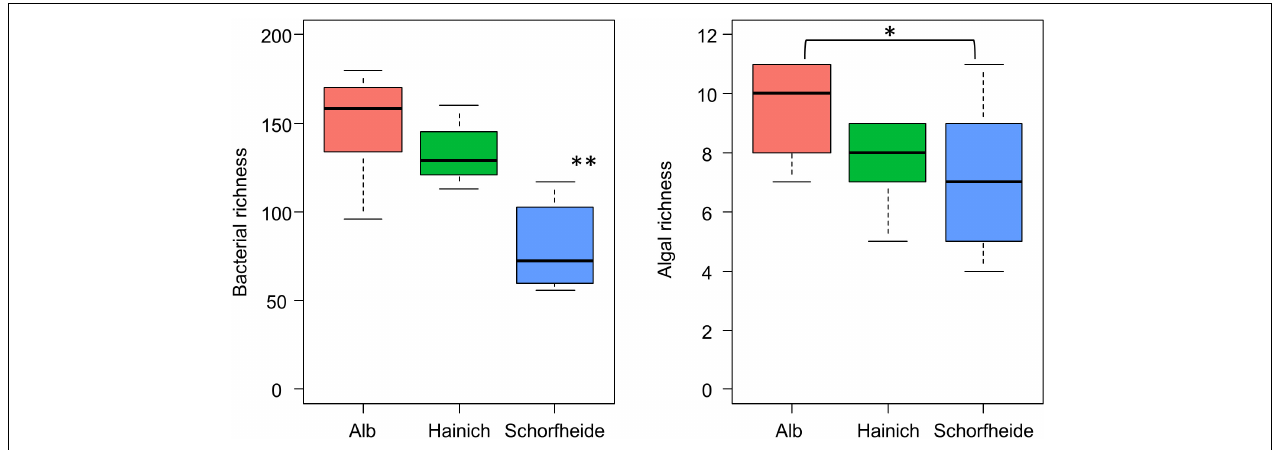
FIGURE 4 | Boxplot visualizes the number of algal species (right) and of bacterial OTUs (left) in biocrusts from three sites ( n = 9 per site); asterisk indicates significant differences (based on ANOVA followed by Tukey post hoc test): ∗ p < 0.05, ∗∗ p < 0.01.